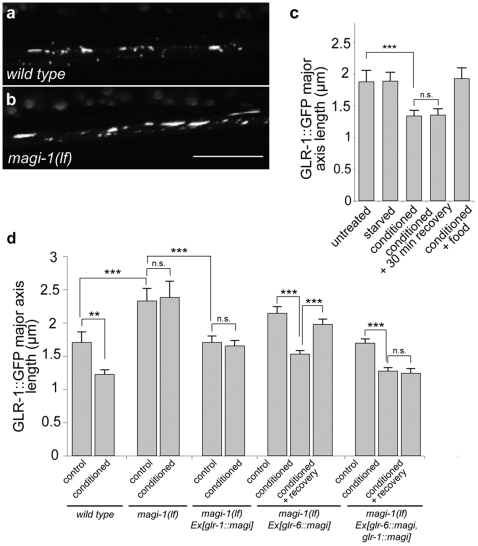
MAGI-1 regulates GLR-1 localization during associative learning and memory formation.Confocal images of the anterior half of the ventral nerve cord of a 4 days old adult a, Naïve wild-type and b, magi-1(lf) worms carrying the glr-1::gfp transgene c, Average size of GLR-1::GFP clusters in the posterior VNC upon starvation in the absence (starved, n = 174) or presence of 0.1% DA (conditioned, n = 181), conditioning followed by 30 minutes recovery in the absence of DA (conditioned+30 min recovery, n = 119), or conditioning in the presence of abundant food (conditioned+food, n = 84). d, Average size of GLR-1::GFP clusters in the posterior VNC upon starvation without (control) or with 0.1% DA (conditioned) or conditioning followed by 30 minutes recovery in the absence of DA (conditioned+recovery) in wild-type and magi-1(lf) animals carrying the indicated transgenes (wild type: control n = 80, conditioned n = 181; magi-1(lf): control n = 86, conditioned n = 55; magi-1(lf); Ex[glr-1::magi-1]: control n = 182, conditioned n = 165; magi-1(lf); Ex[glr-6::magi-1]: control n = 202, conditioned n = 288, conditioned+recovery n = 186; magi-1(lf); Ex[glr-1::magi-1, glr-6::magi-1]: control n = 233, conditioned n = 271, conditioned+recovery n = 253). Three independent experiments were quantified, and three independent transgenic lines were tested for each construct. Error bars indicate average±S.E.M. Significance between datasets as indicated was tested with two-tailed student's t-test (n.s. p>0.05, ** p<0.01, *** p<0.001).